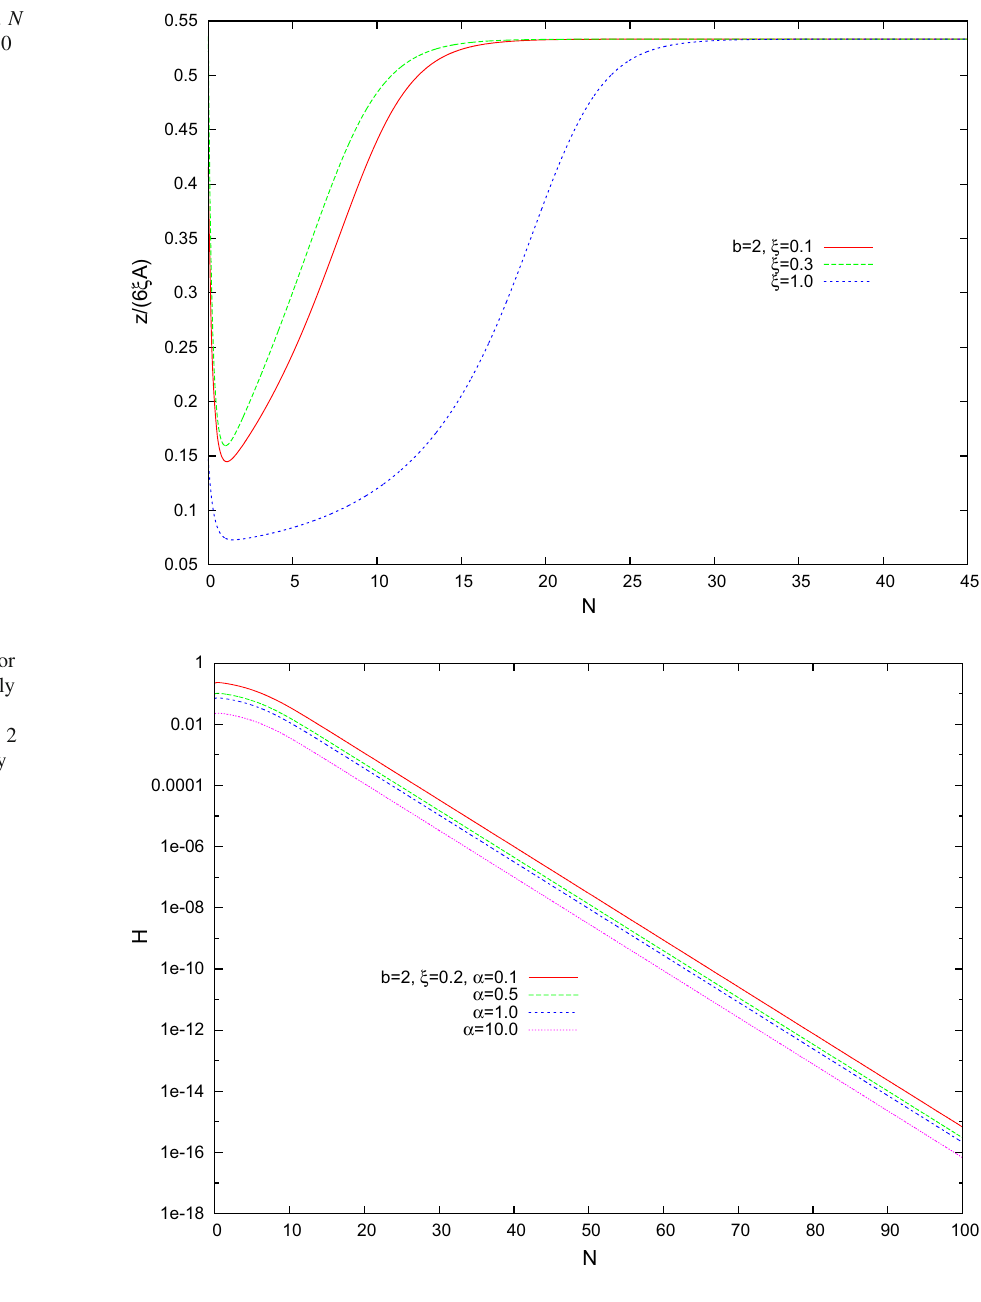
vs. N 6 ξ(cid:15)